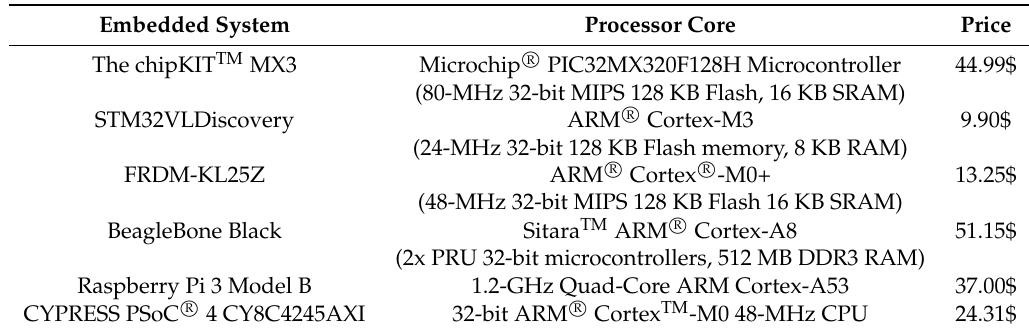
Table 1. Embedded systems’